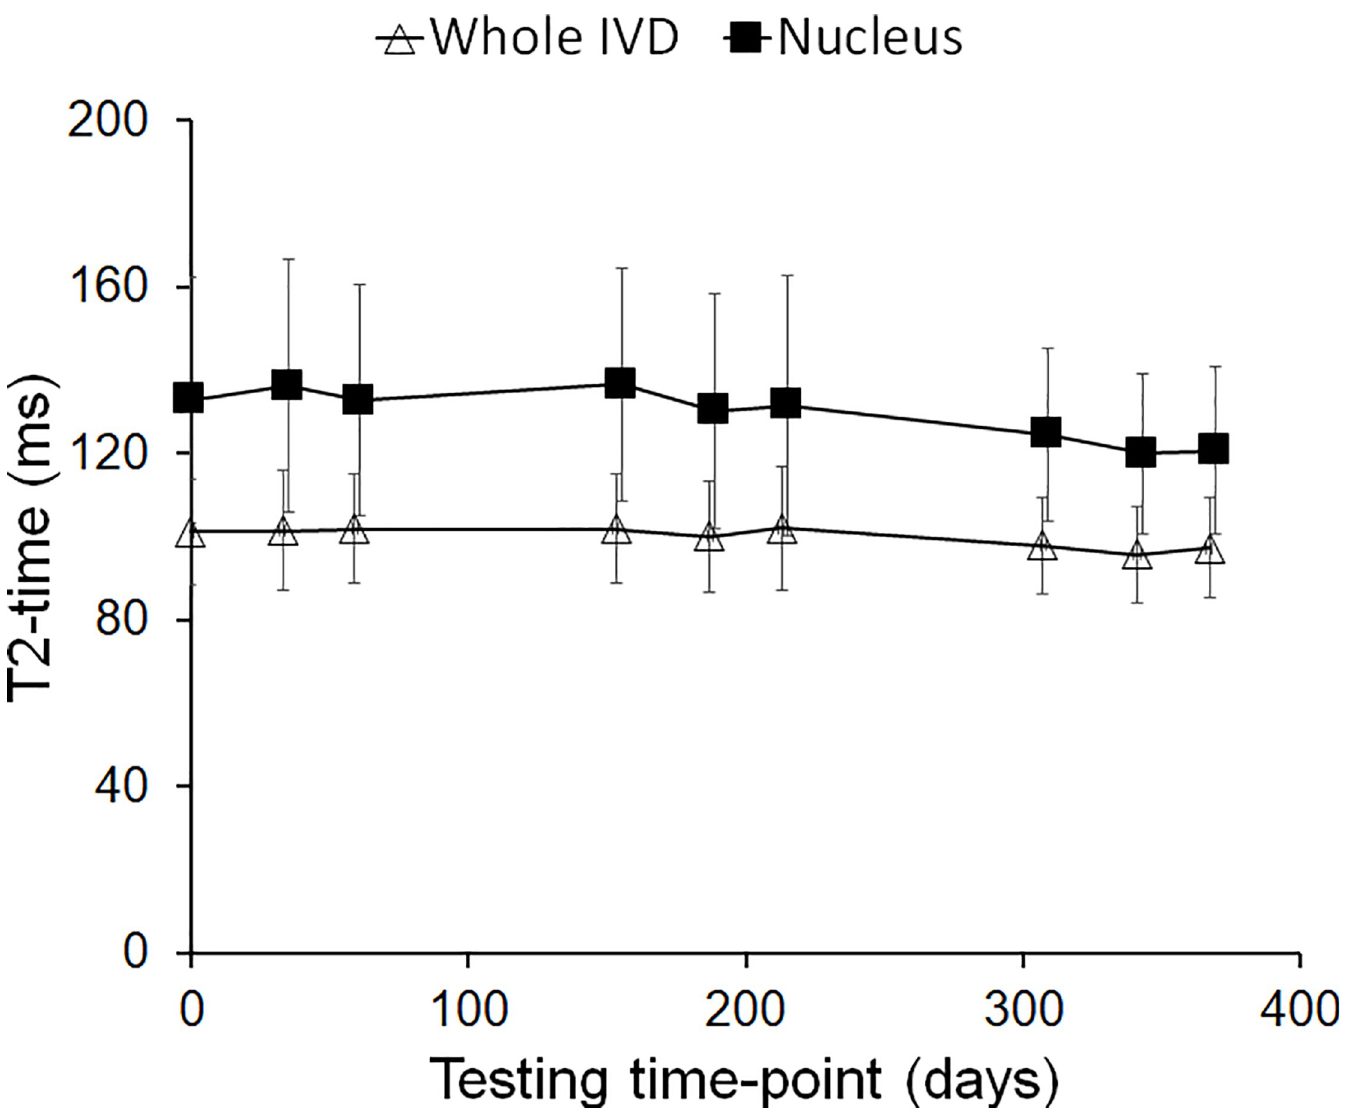
Fig 3. Whole and nuclear intervertebral disc (IVD) T2 across all scanning time-points. Values are mean (SD) of data averaged across all lumbar discs. Analysis of the limits of agreement (S1 Table) showed agreement between baseline and follow-up testing time-points. The subtle downward slope over time in both parameters was not significant (p > 0.76) on further linear regression